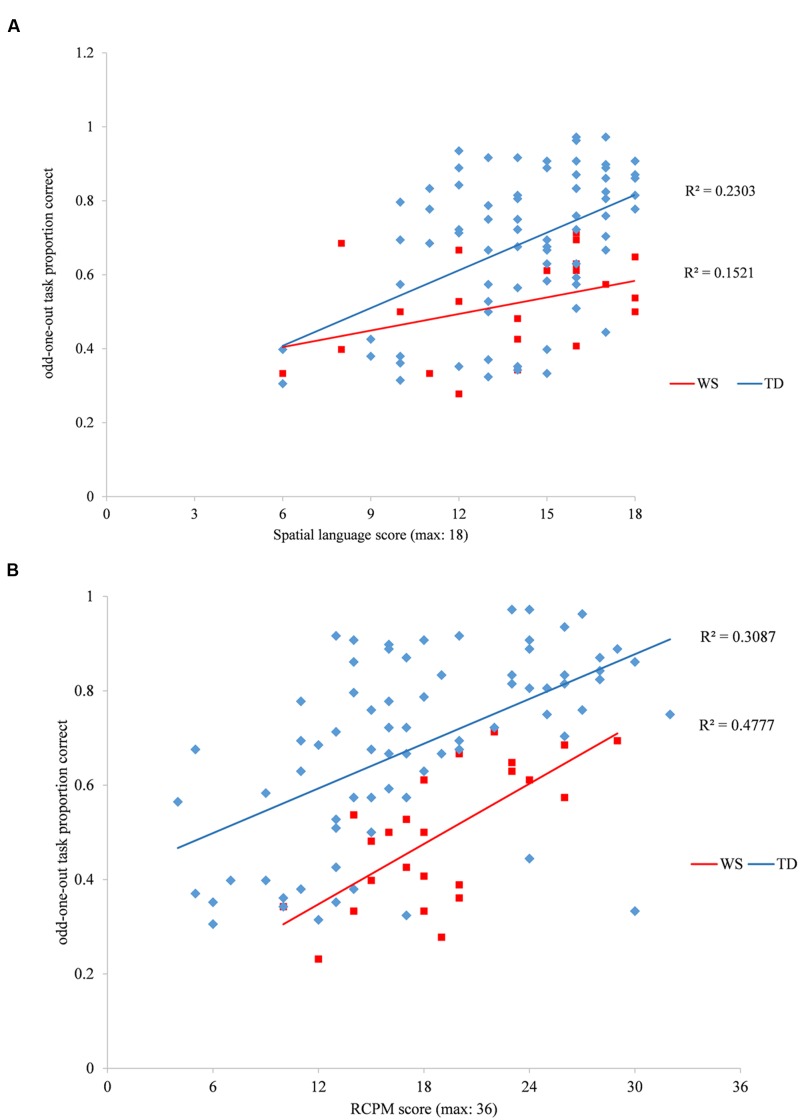
(A) Williams syndrome (WS) and typically developing (TD) trajectories of odd-one-out performance when plotted against spatial language composite (comprehension and production) score. (B) WS and TD trajectories of odd-one-out performance when plotted against Ravens Coloured Progressive Matrices (RCPM) score.